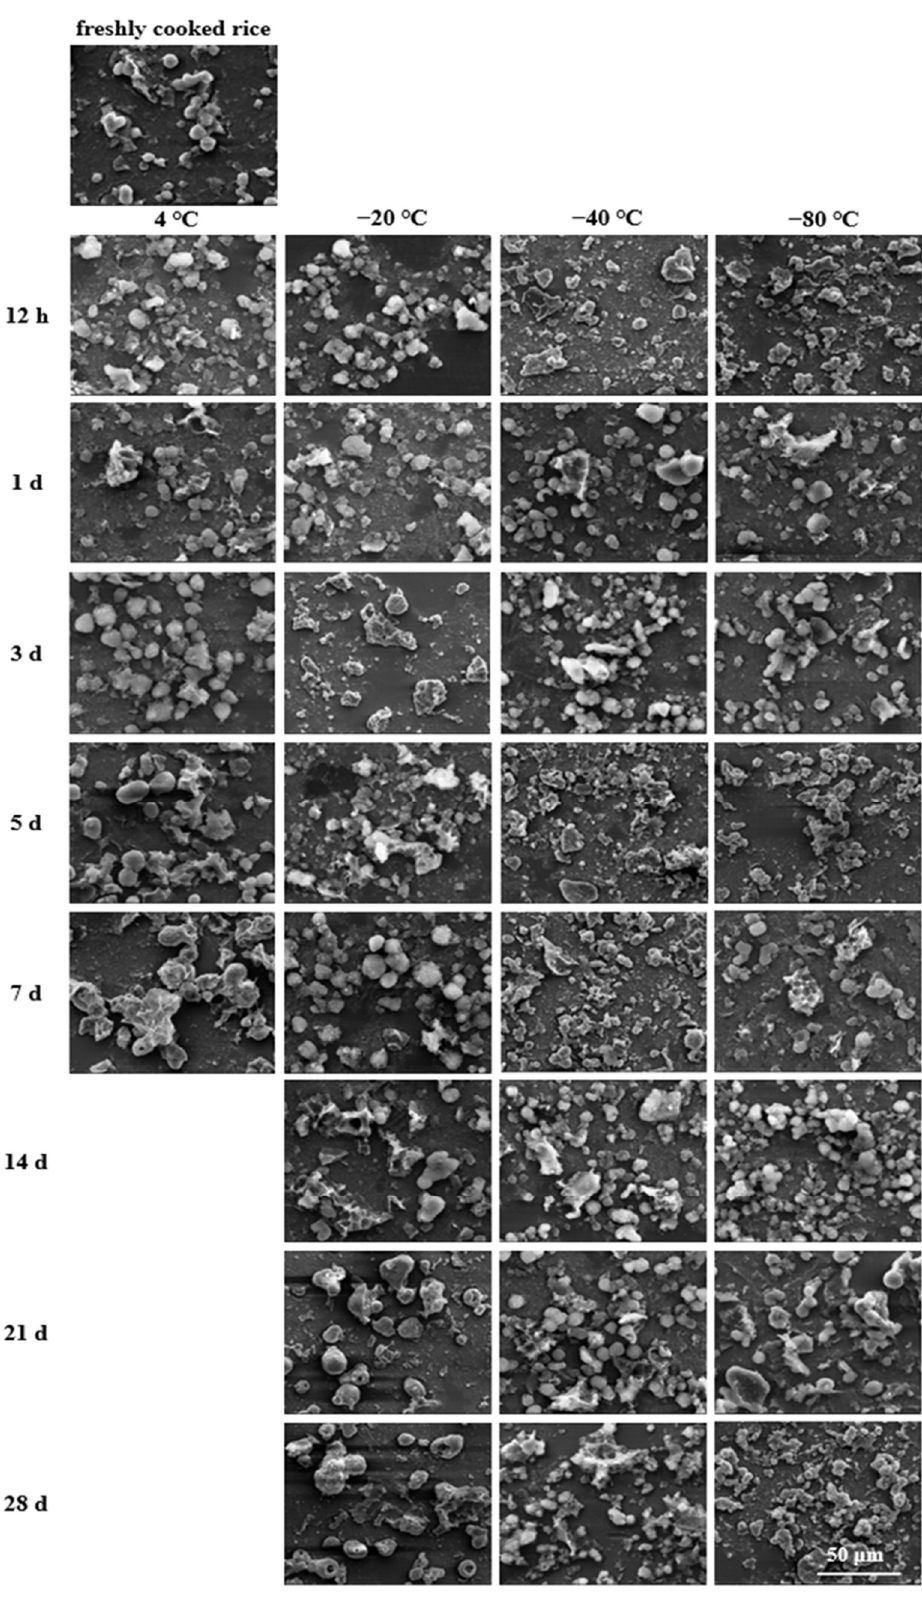
Figure 7. Microstructural changes of fresh and stored rice samples digested in simulated intestinal digestion for 120 min (2400×, bar = 50 μm).